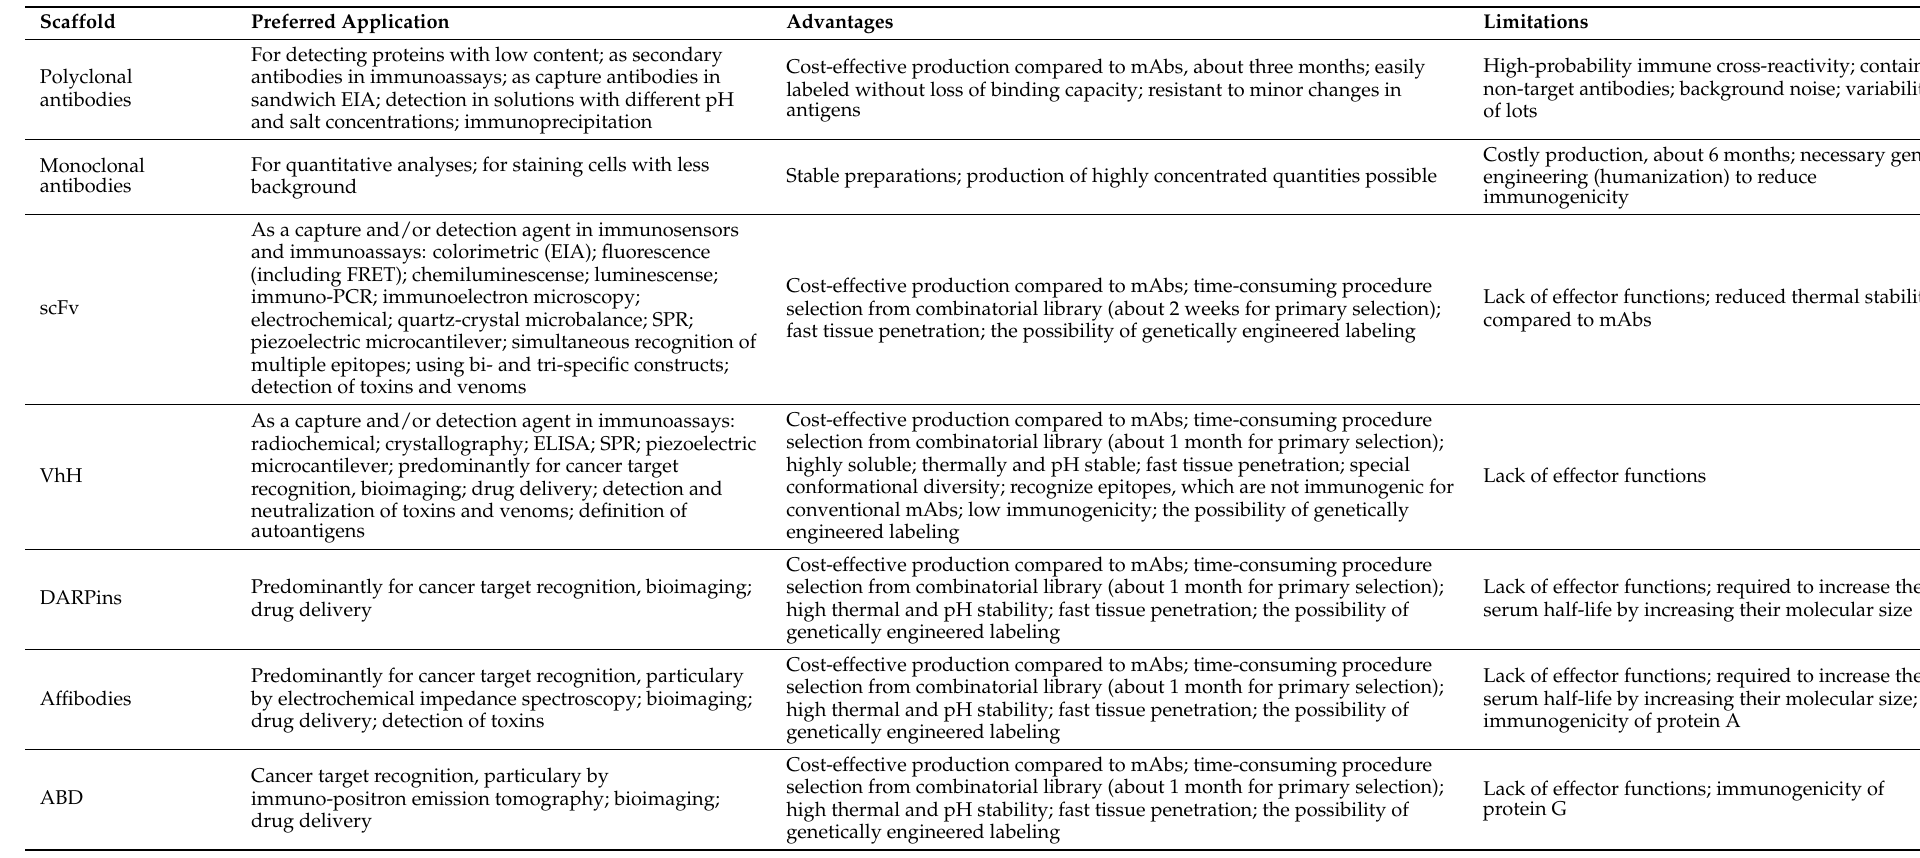
Table 2. Practical application features of analyte-binding